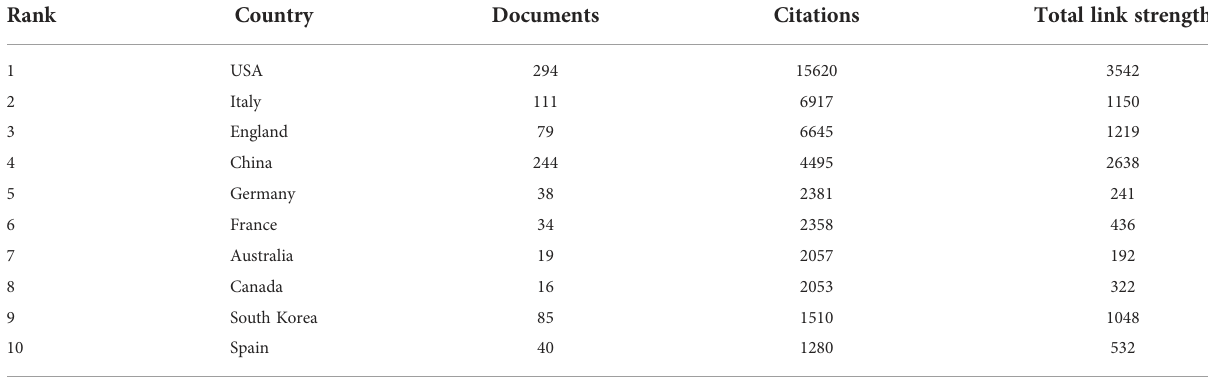
TABLE 2 The number of citations of publications on DMED in the top 10 countries.